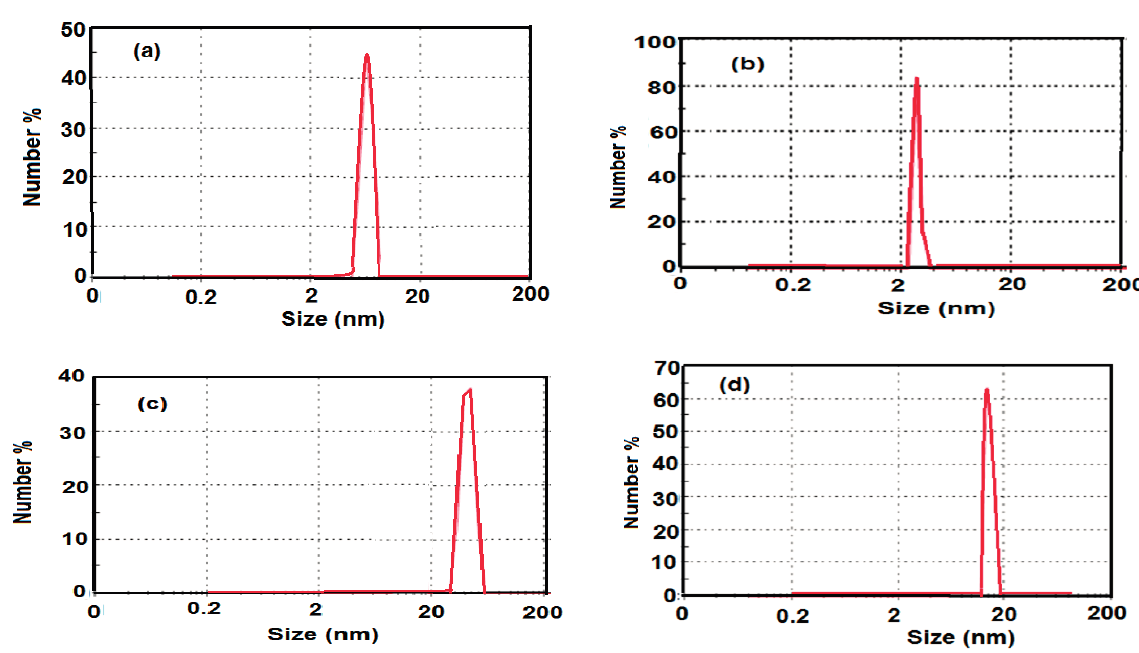
Figure 3. DLS of the prepared magnetite ( a ) absence of iodine; ( b ) presence of iodine; ( c ) presence of myrrh; and ( d ) presence of myrrh and